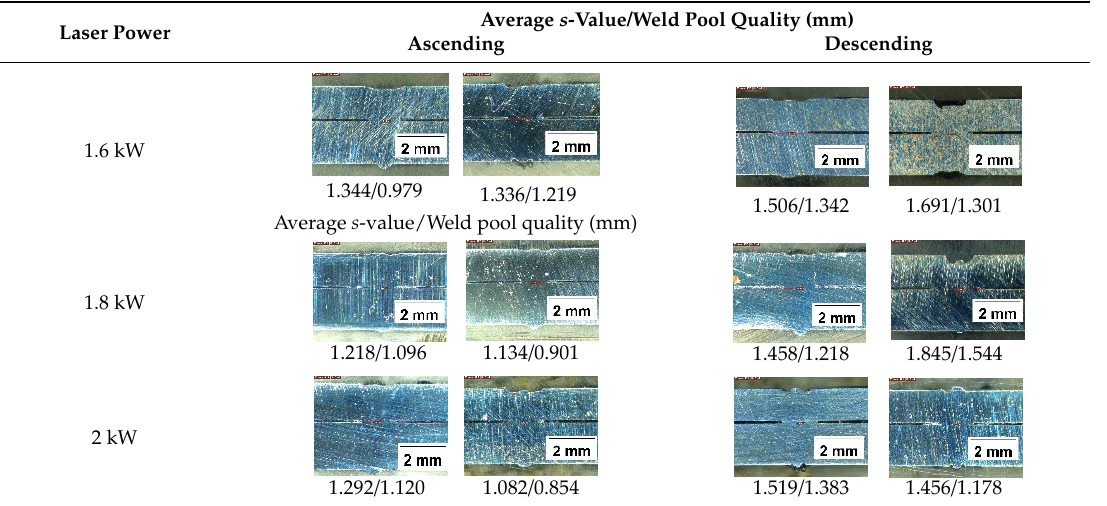
Table 6. The laser welding experimental data for experiment #1 ‐ 1.